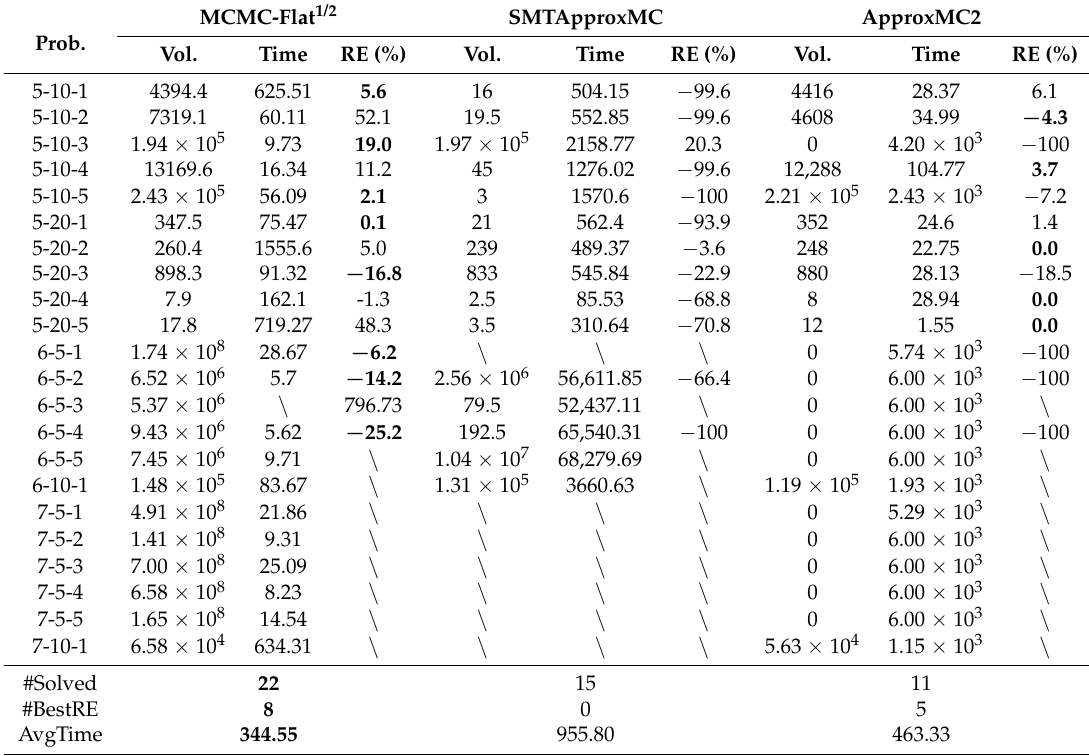
Table 6. Comparison of MCMC-Flat 1/2 , SMTApproxMC and ApproxMC2 on convex bodies.